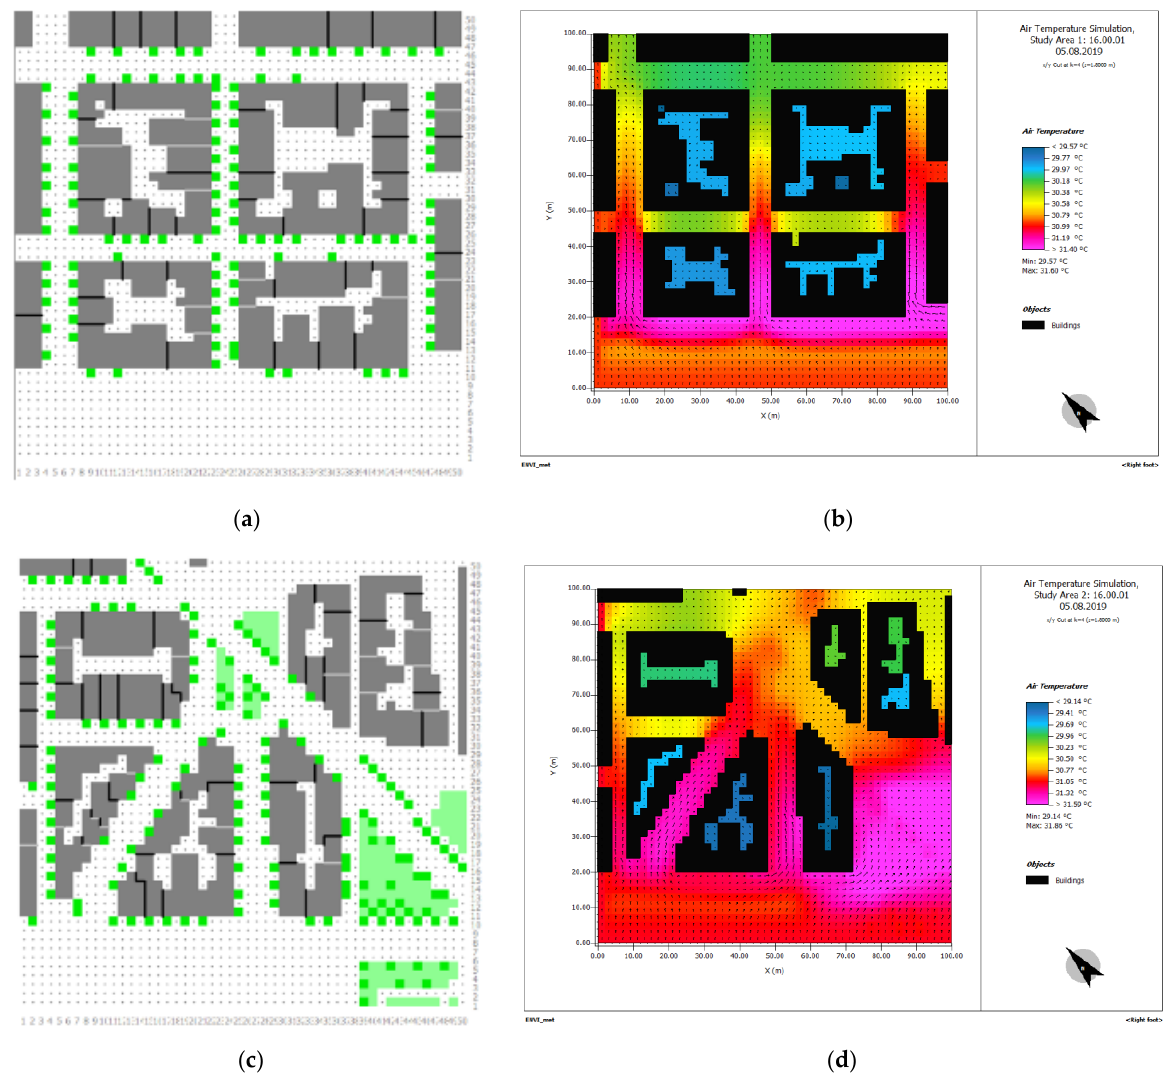
Figure 10. ( a ) Two-dimensional display of the first section where the buildings are shown in gray and the positions of the tree planting in green; ( b ) Air temperature simulation for the first section of the study area; ( c ) Two-dimensional display of the second section where the buildings are shown in gray and the positions of the tree planting in green; ( d ) Air temperature simulation for the second section of the study area, ENVI-met© software.